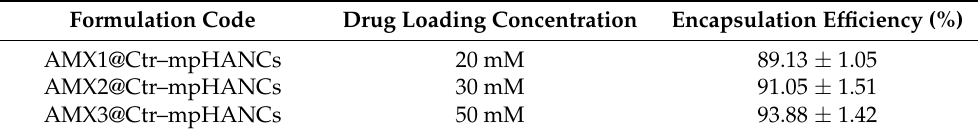
Table 1. Encapsulation efficiency (%) of the formulations (n = 3, mean ± SD).